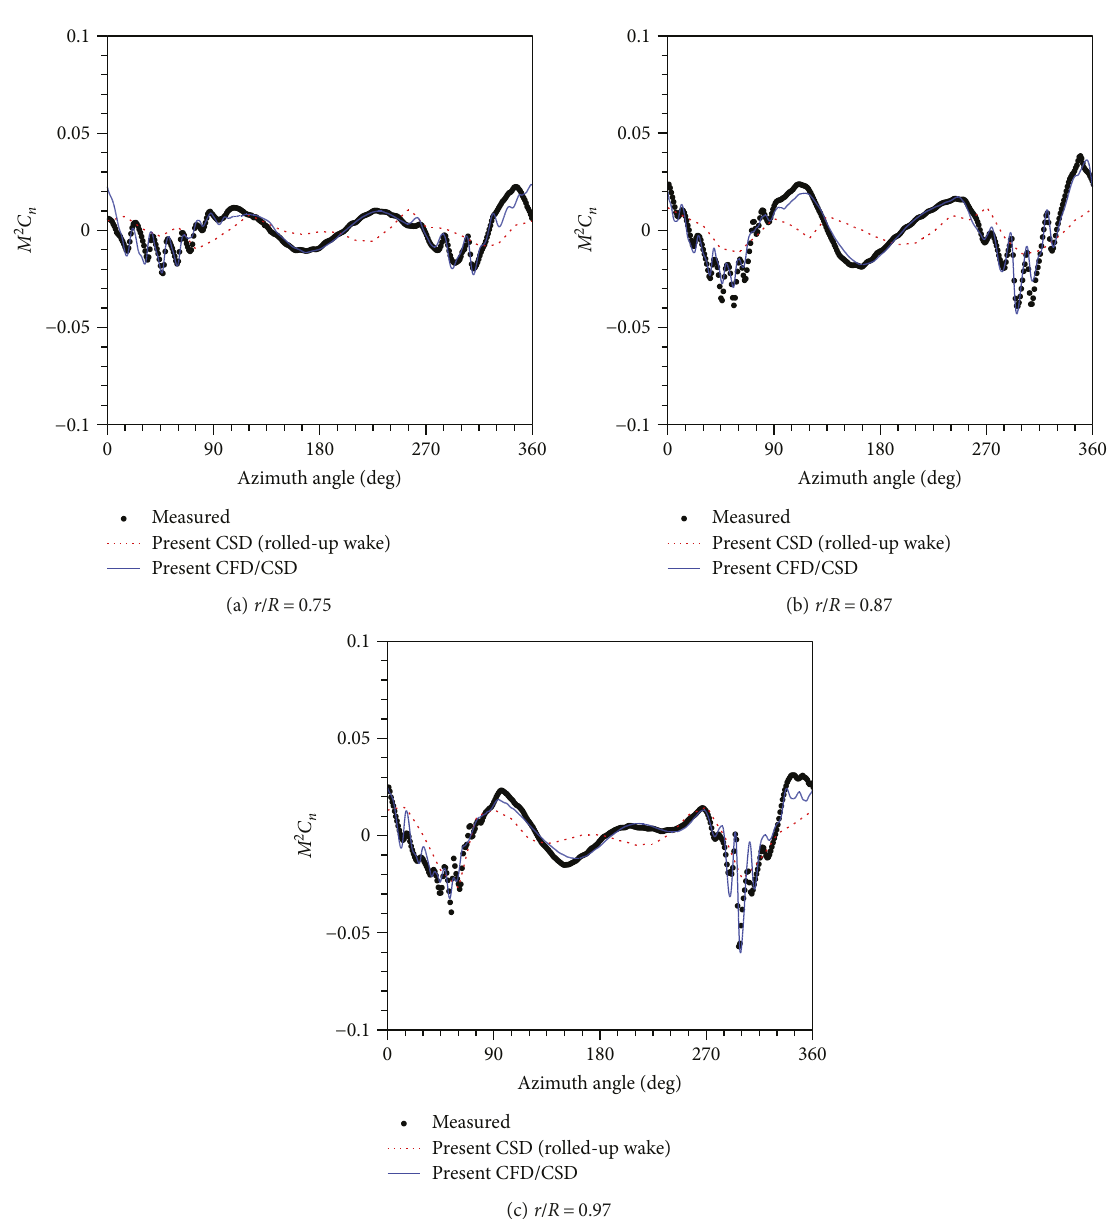
Figure 14: Correlation of vibratory components (3/rev and higher) of M 2 C